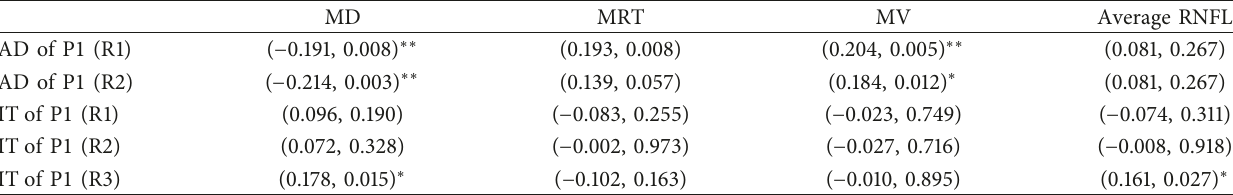
Table 4: Correlation between visual functional parameters and structural